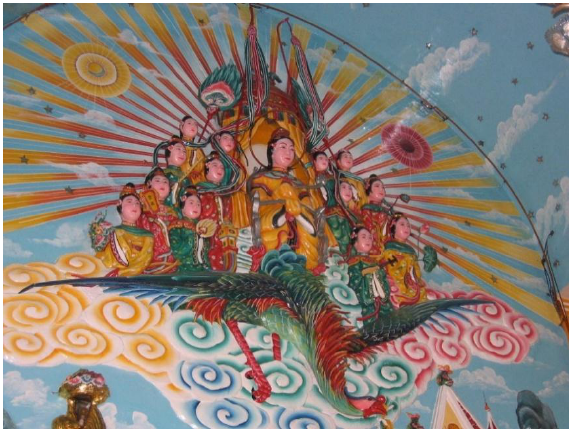
Figure 1. Statue of the CaodaiMother Goddess and nine Immortal Maidens at the main altar in